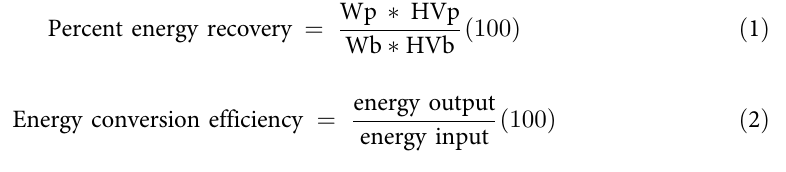
Table 1. Proportion of biomass in each treatment. Biomass HHV (MJ/kg) Treatments (%) Cotton gin trash 17.9 Cow manure